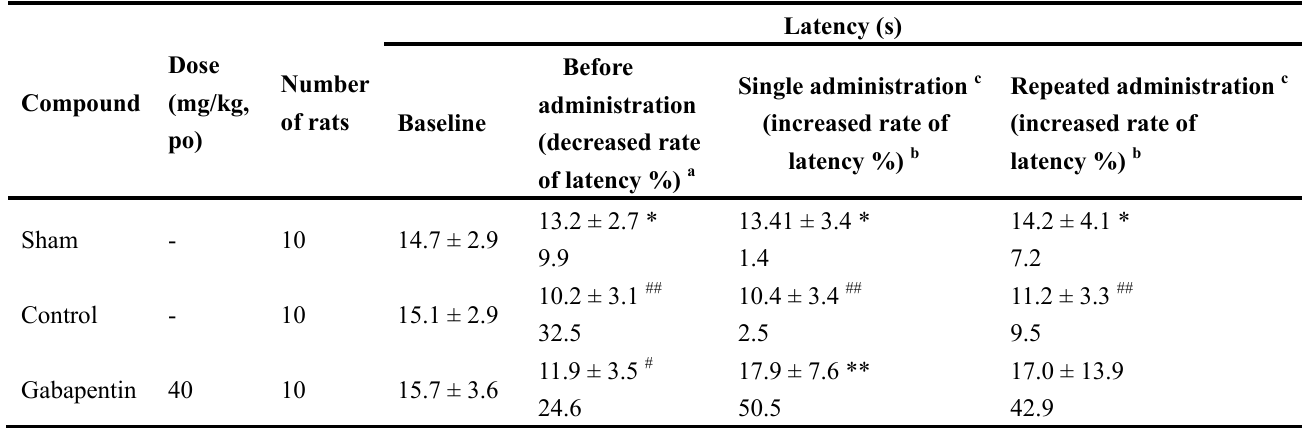
Table 6. Effects of compounds on latency of thermal stimulation in the CCI